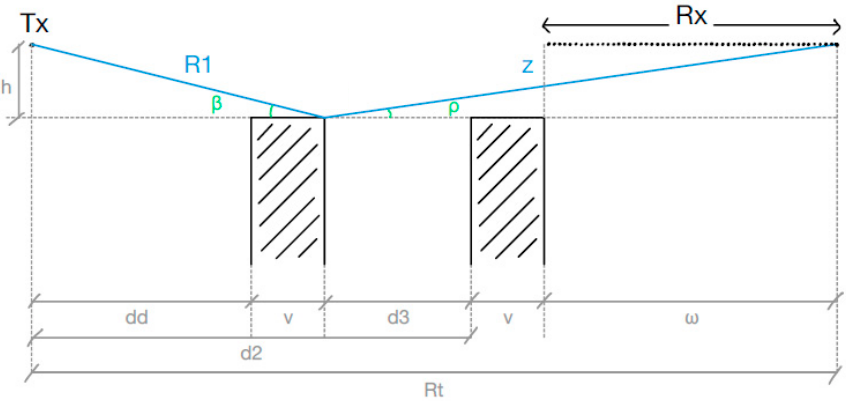
Figure 4. Second single diffraction (Edif2) of the considered LOS scenario.